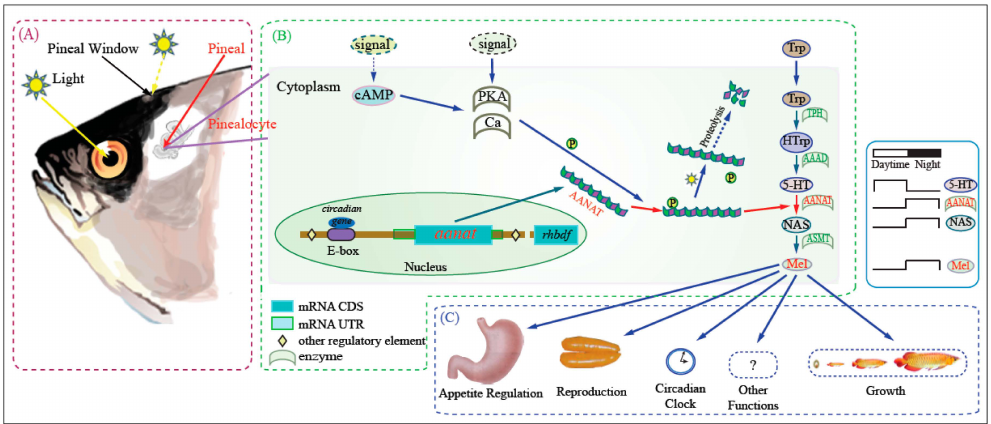
Figure 1. Outline of melatonin biosynthesis and function. Amphibians, reptiles, and fishes can detect light by photoreceptor cells of the retinae and pinealocytes of the pineal glands. ( A ) Photic detecting and transforming system includes the retina photoreceptor cells and the pinealocytes; ( B ) Melatonin synthesis pathway is summarized in the frame; ( C ) Melatonin performs its various biological functions in different tissues and at different growth/development phases through binding to its